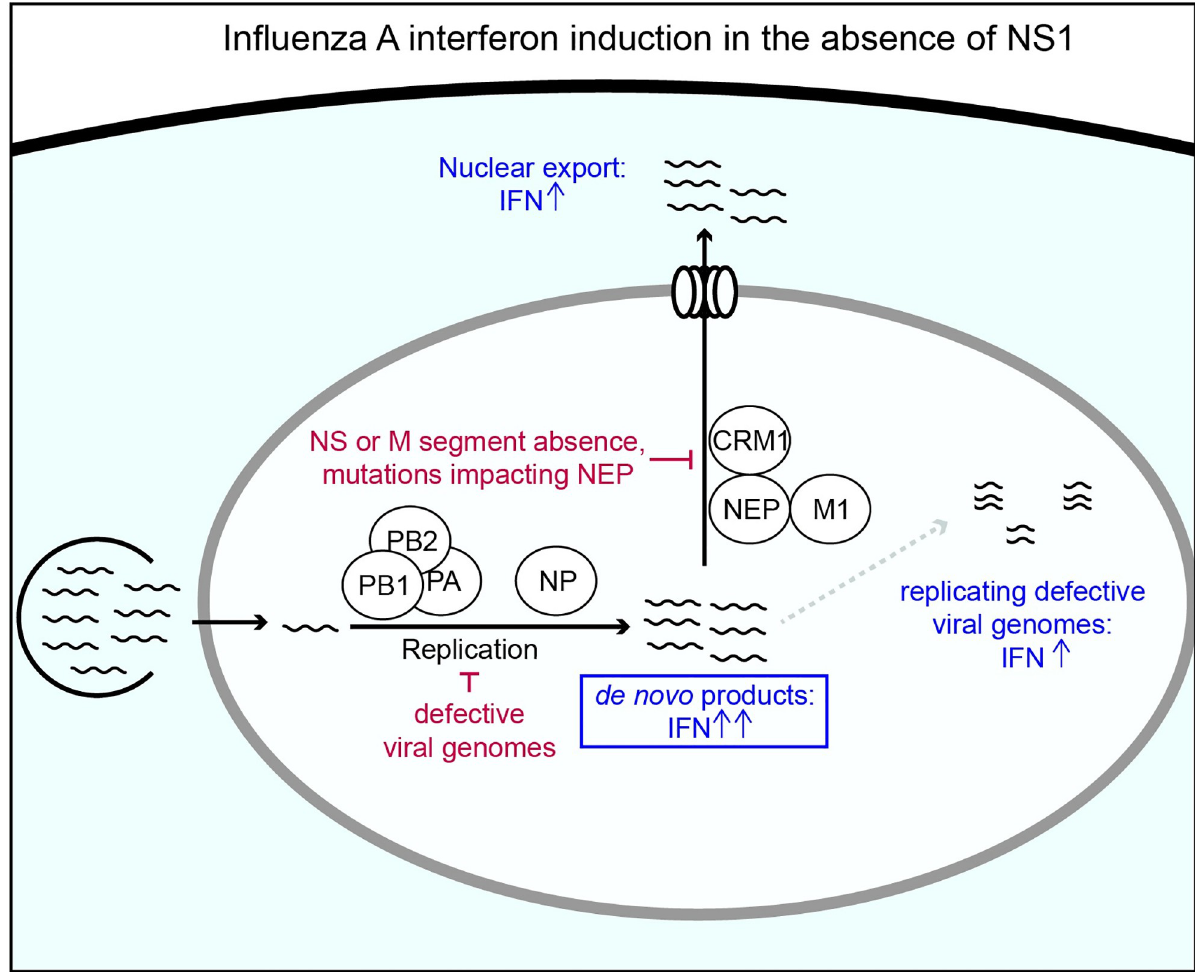
Fig 7. Conditions required for, supporting, and suppressing, interferon induction in the absence of NS1. Summary of major conclusions from this work. In brief, we find that both replication and export are required for maximal interferon induction in the absence of the NS1 antagonist, and that, additionally, the presence of replicating defective viral genomes greatly enhances the interferon response. The boxed step is absolutely required for the increase in interferon in the absence of NS1, whereas nonboxed steps modulate the process. Conversely, we find that the absence of the NS or M segments, mutational inactivation of NEP, or general suppression of replication, potentially through defective genome formation, all act to decrease detection of an influenza population lacking NS1. As discussed in the text, the confluence of these requirements is unlikely to occur with any great frequency in a viral population alongside the inactivation or loss of